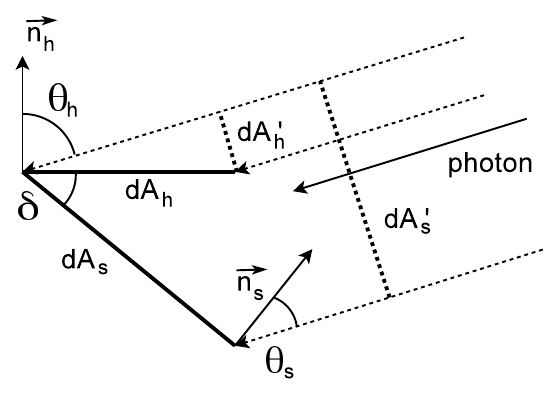
Fig. 2. Translation from slope-parallel to horizontal irradiance. dA S is the sloped surface element, dA h is the corresponding hori- zontal surface element. dA 0 and dA 0 p are the corresponding projec- S tions normal to the photon direction. n S and n h are the normals to the sloped and horizontal surface